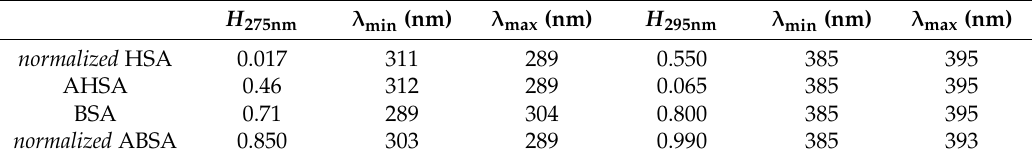
Table 2. Relative peak composition (parameter H ) of albumin tryptophanyl residues at λ ex 295 nm and λ ex 275 nm. H 275nm λ min (nm) λ max (nm) H